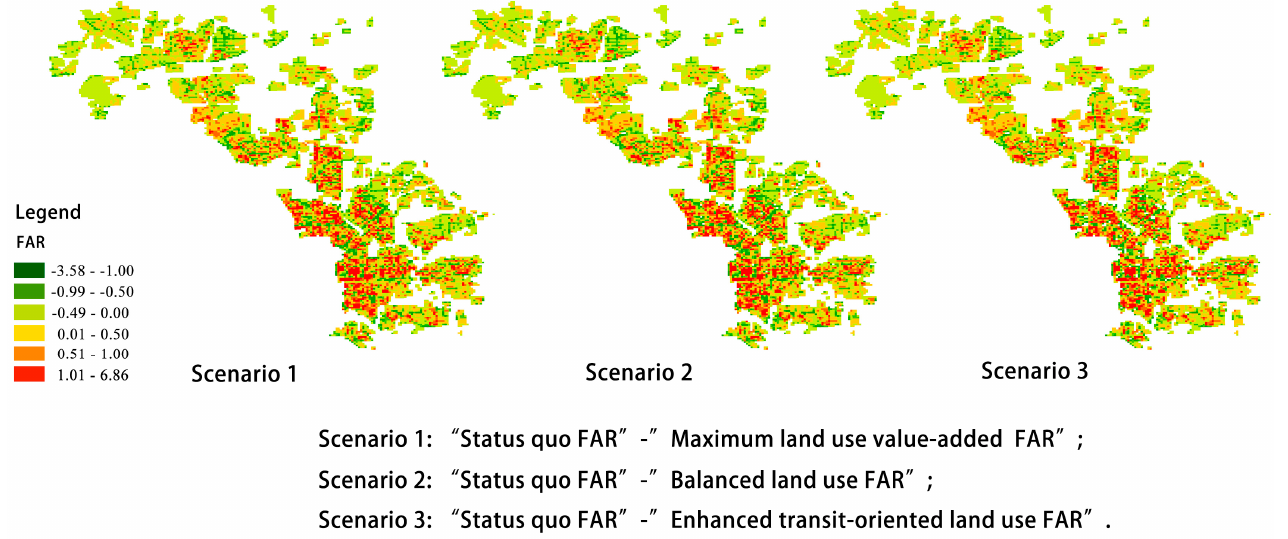
Figure 4. Difference between the theoretical ideal FAR and the status quo FAR in the three scenar- ios.